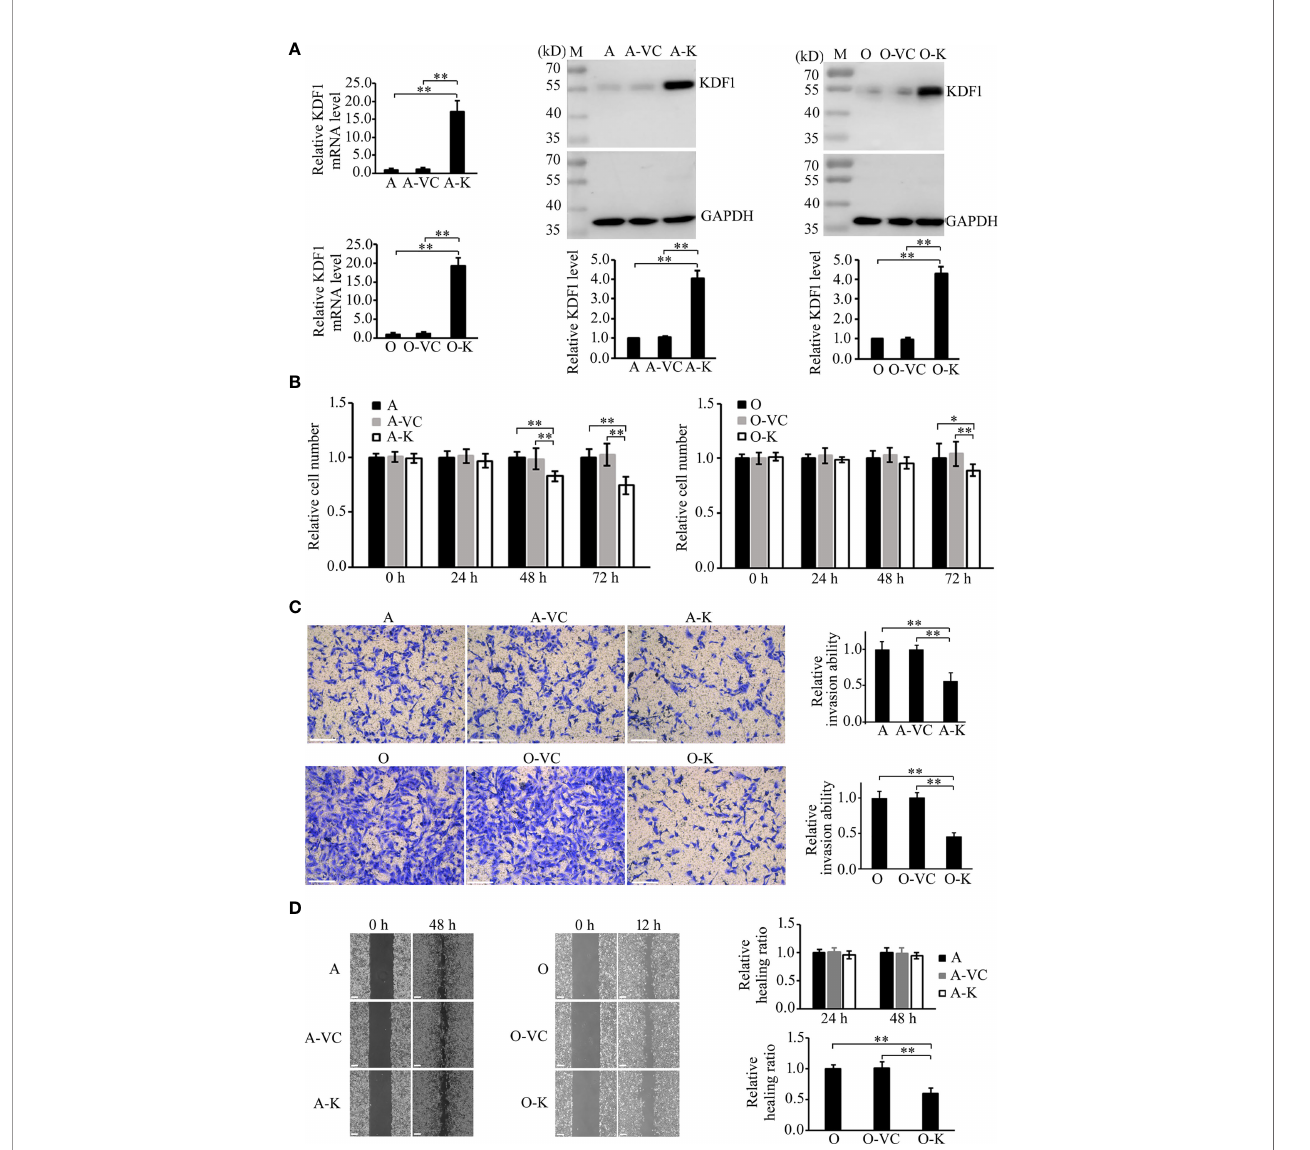
FIGURE 4 | Effect of KDF1 overexpression on the proliferation, migration and invasion of ccRCC cells. Two ccRCC cell lines, 786-O and ACHN, were used in the experiments. The KDF1 overexpression ccRCC cells, 786-O-KDF1 and ACHN-KDF1, were constructed via stably infecting 786-O and ACHN cells with a recombinant KDF1 expression lentivirus. The overexpression of KDF1 in ccRCC cells were con fi rmed by quantitative RT-PCR and Western blot (A) and the in fl uence of KDF1 overexpression in the proliferation (B) , migration (C) and invasion (D) of the ccRCC cells were evaluated by using CCK-8, wound healing and Matrigel invasion chamber methods. All the experiments were repeated at least three times. A, untransduced ACHN cells; A-VC, control virus transduced ACHN cells; A-K, KDF1 overexpression ACHN cells; O, untransduced 786-O cells; O-VC, control virus transduced 786-O cells; O-K, KDF1 overexpression 786-O cells. *p < 0.05; **p < 0.01. Scale bar,